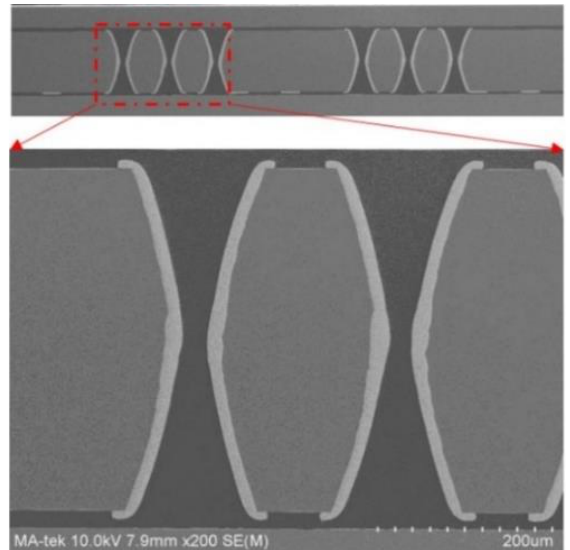
Figure 17. Cross-sectional SEM image of TGV metallization.